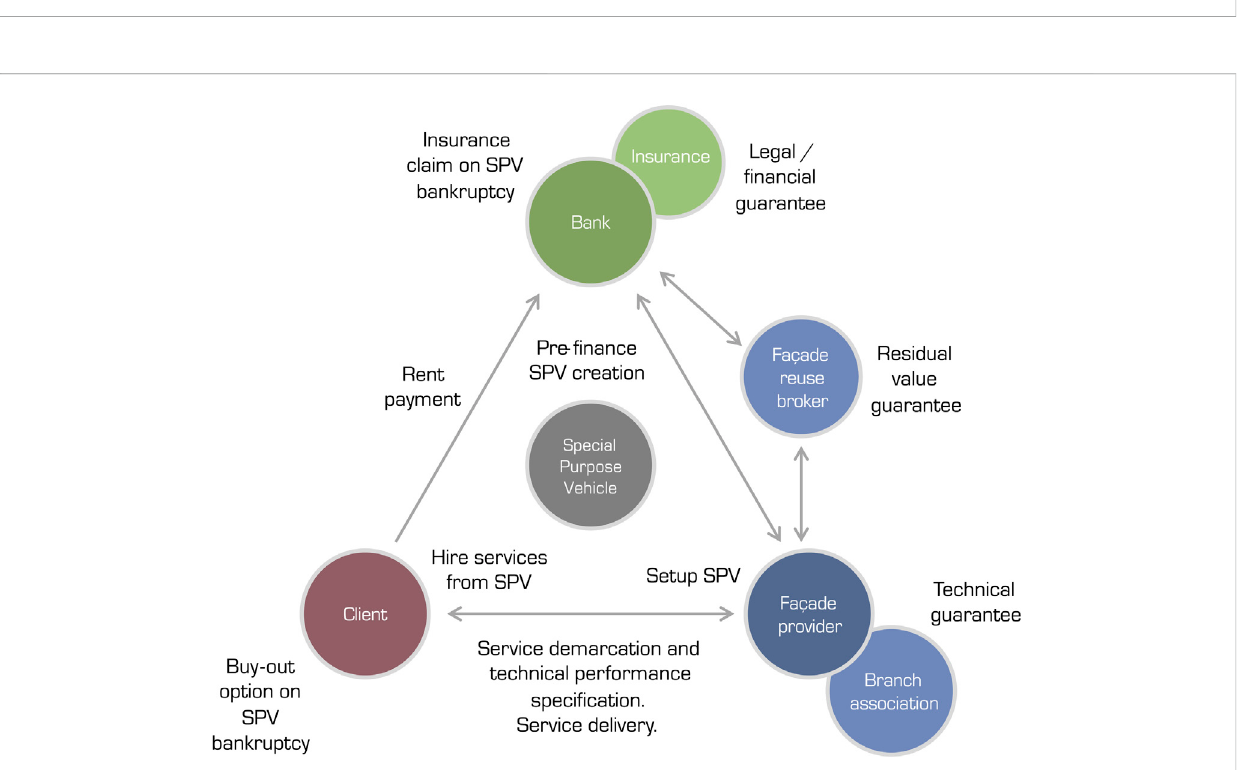
FIGURE 8 ExtendedstructuraldiagramoftheFaaS “ SPV ” model,showingstakeholdersorcontractual/ fi nancialproductsintendedtoguarantee-andtherefore reduce the perceived risks and consequential costs of - a FaaS system. First published in (Azcarate-Aguerre et al.,